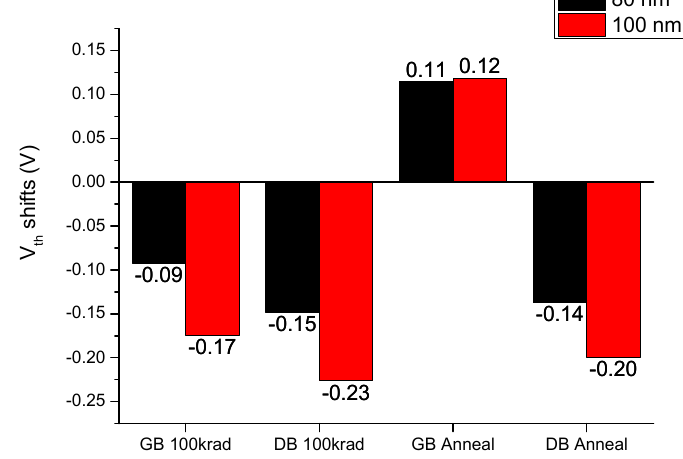
Figure 6. Threshold voltage shifts for 80 nm and 100 nm gate oxide devices under gate bias and drain bias (RB) conditions, after receiving 100-krad(Si) TID and annealing.